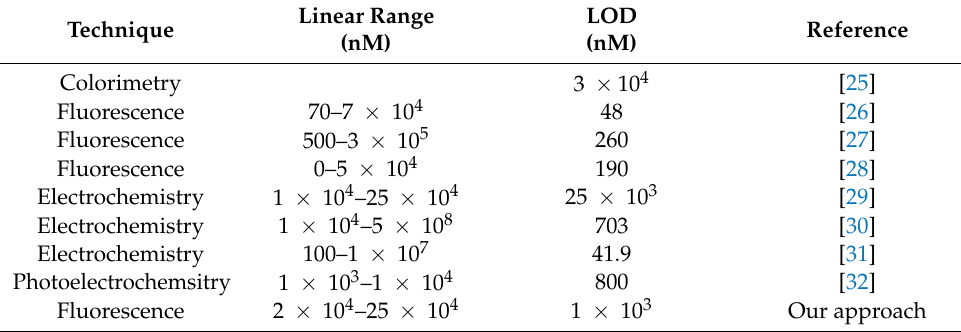
Table 1. GSH detection performance of our approach and previous